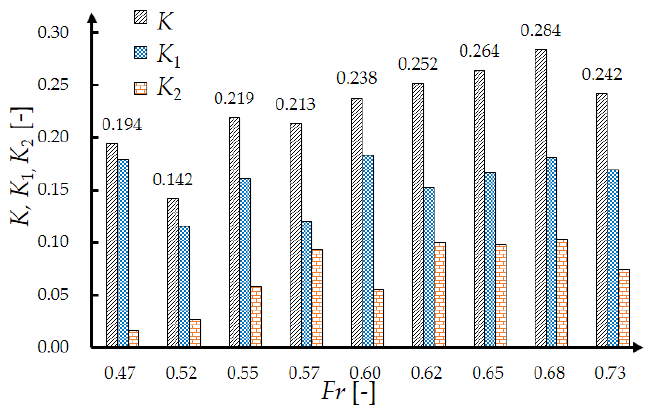
Figure 11. K 1 , K 2 , and K caused by